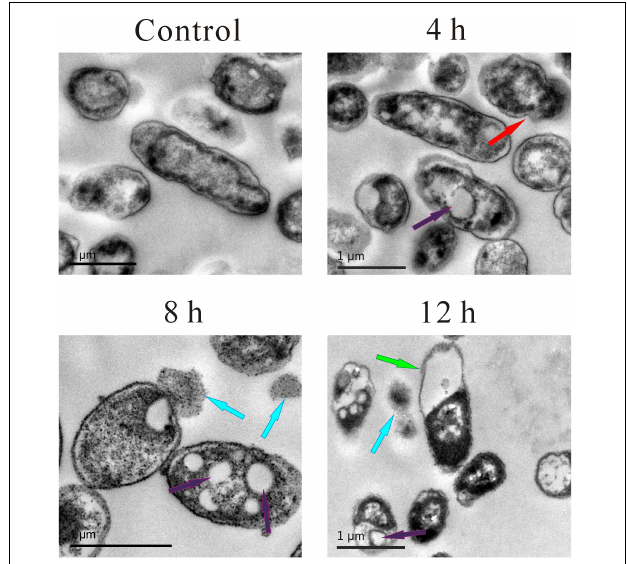
FIGURE 4 | Transmission electron microscopy (TEM) photography of A. hydrophila planktonic cell. (Control) Untreated group; (6, 12, 18 h) bacteria treated by SMEO at 1 × MIC for 6, 12, and 18 h, respectively. The red, purple, blue, and green arrows indicate wrinkled surfaces, vacuoles inside the cytoplasm, the leakage of cytoplasm, and the cell wall without cytoplasm inside, respectively.